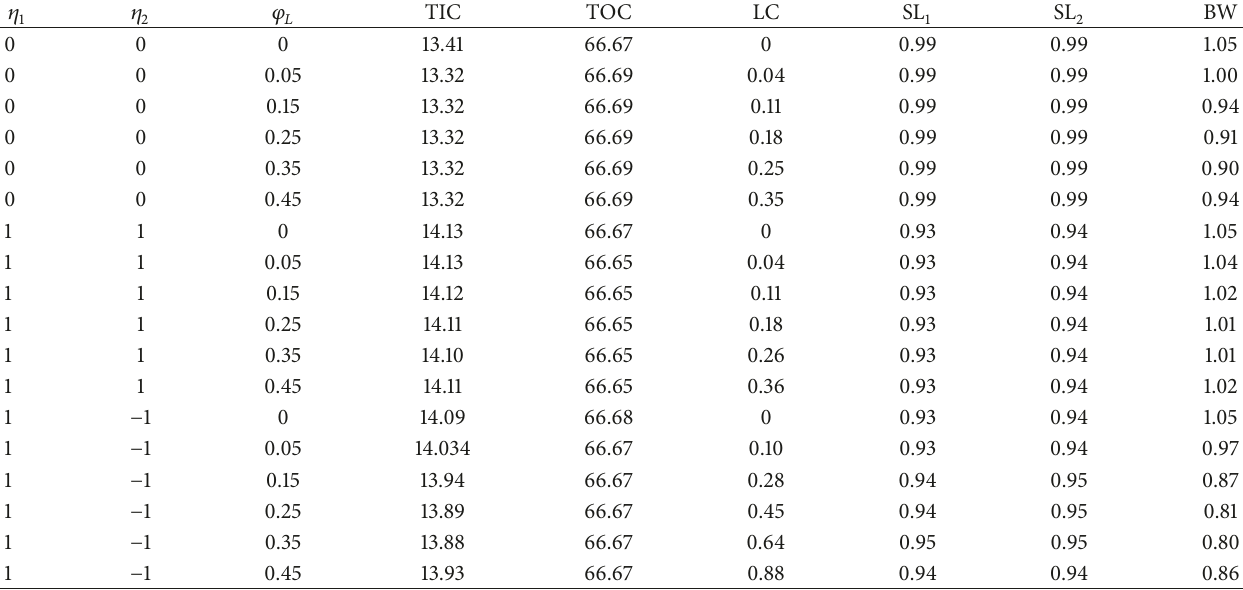
Table 2: The computational results of performance measurements in scenario 𝜉 1